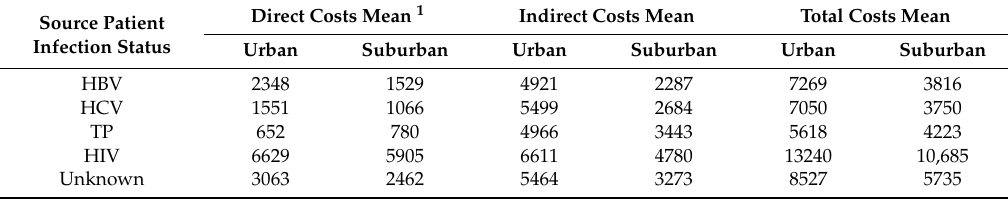
Table 4. Costs of the BBF exposure management categorized by the locations in Beijing (in Chinese RMB). Table4. Costsof theBBF exposure managementcategorized bythe locations inBeijing (inChinese RMB). Source Patient Infection